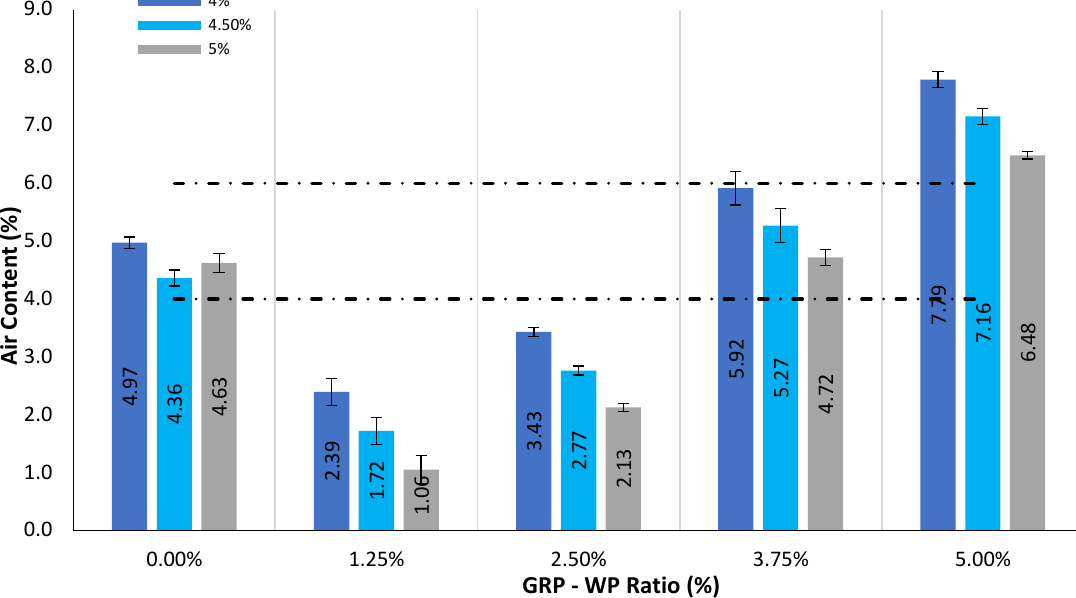
Figure 8. Comparison of air content (Va) results for the 45 samples tested.